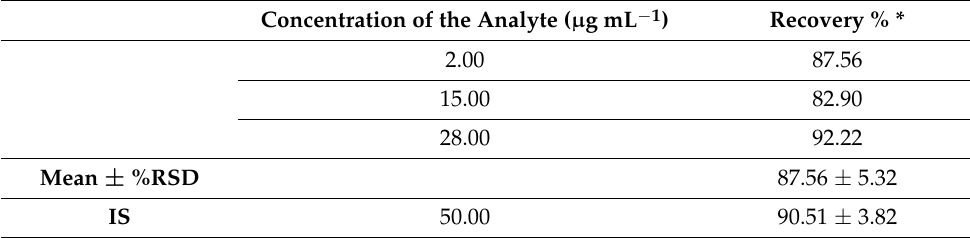
Table 3. Extraction recovery results of the studied drugs in spiked human